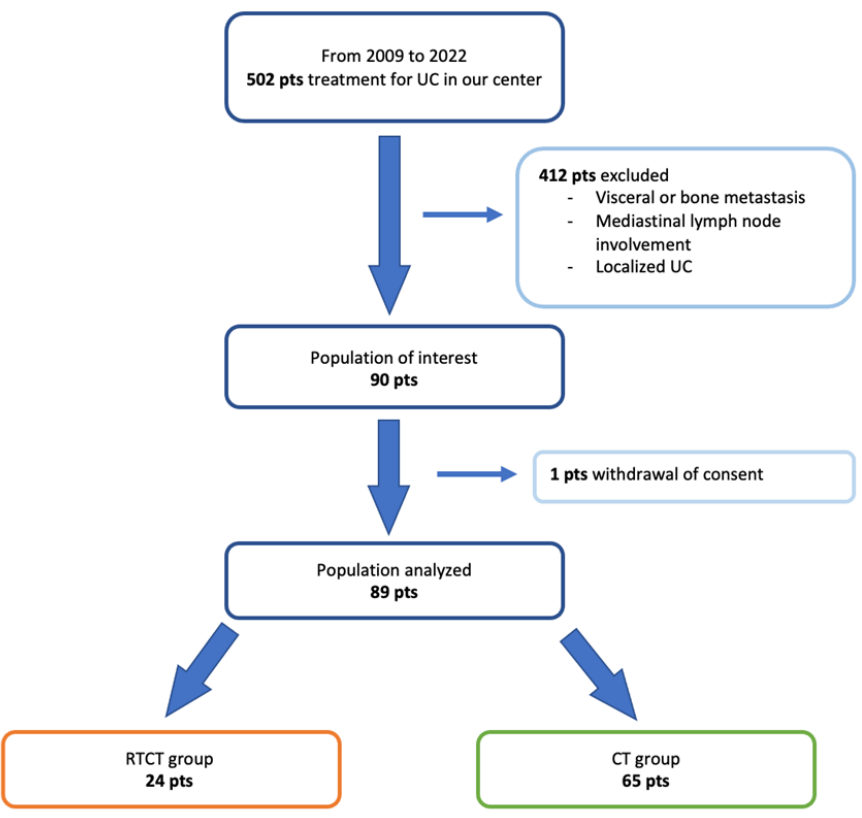
Figure 1. Flow chart. Pts: patients; UC/urothelial cancer; RTCT group: radiotherapy and chemother- apy group; CT group: chemotherapy group.